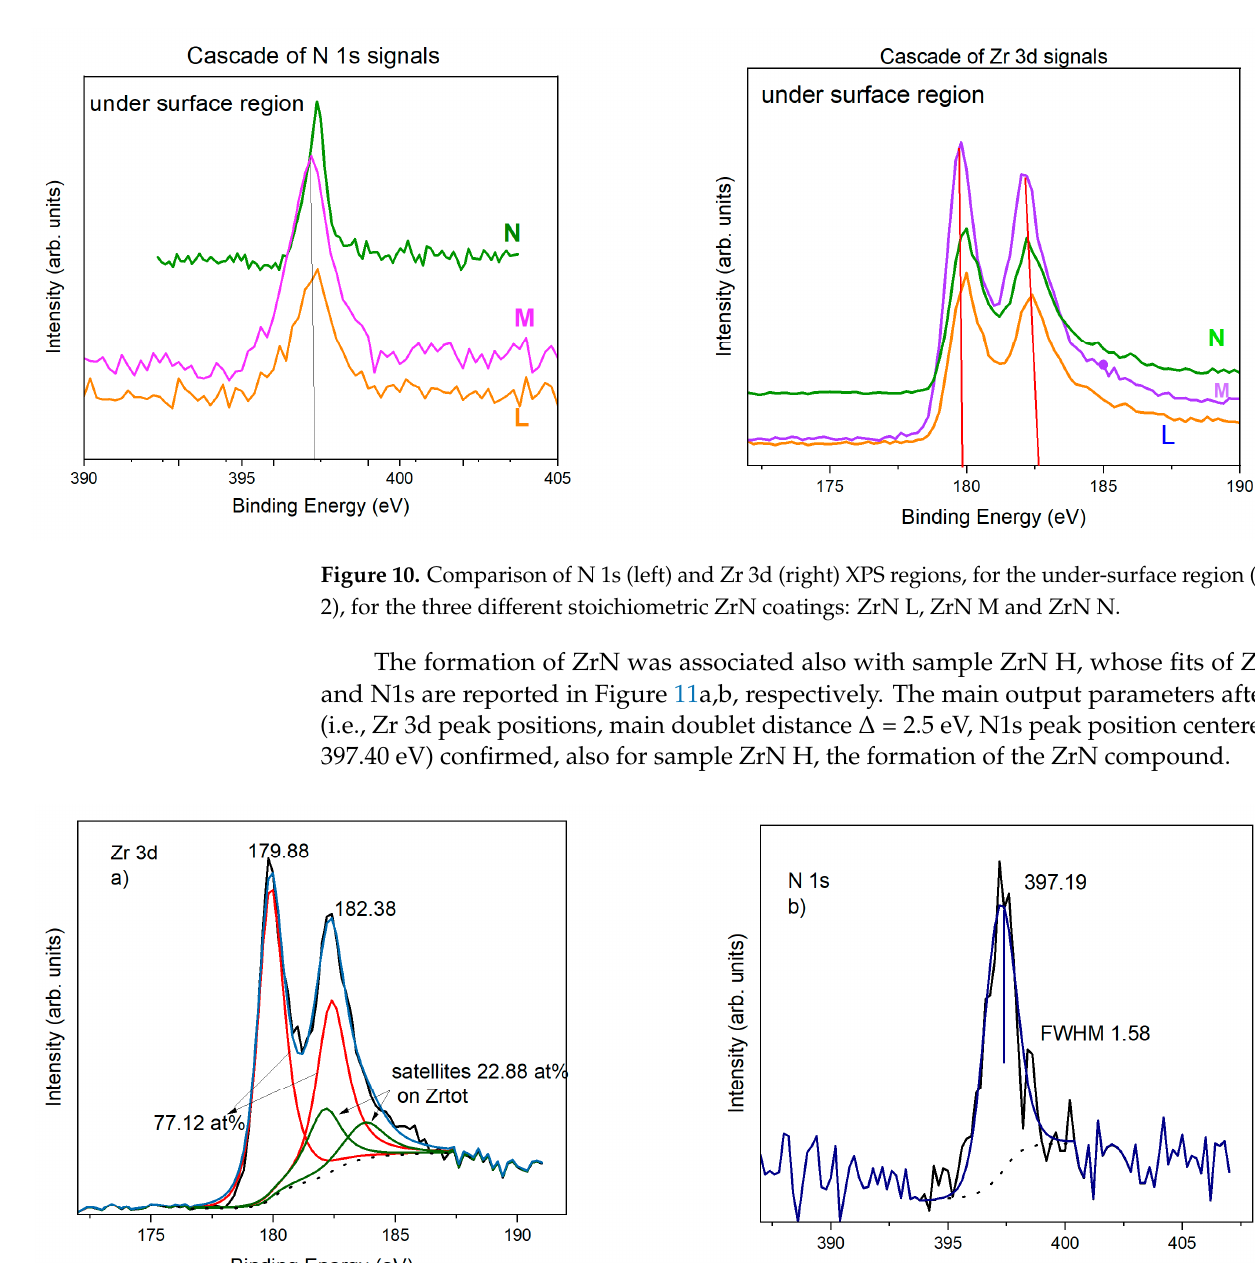
Figure 11. Zr 3d, ( a ) and N 1s ( b ) fitted regions at level 5 from the surface, after Ar+ in situ sputtering Figure 11.Zr 3d, figure 11 a) and N 1s figure 11 b) fitted regions at level 5 from the surface, after Ar+ of sample in situ sputtering of sample H.